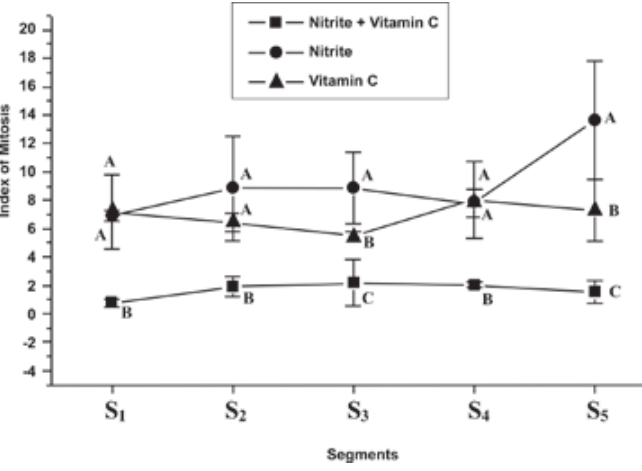
FIGURE 3 - Means and standard deviations of the Index of Mitosis in the segments according to group and